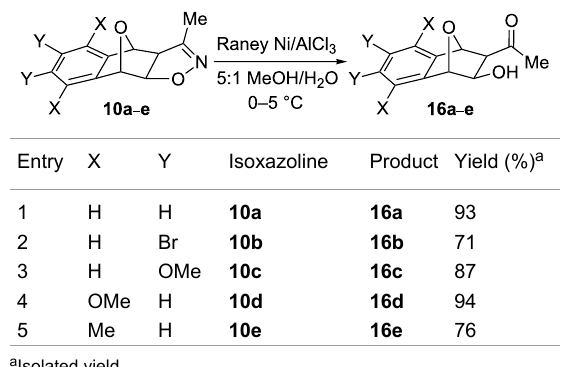
Table 2: Effects of arene substitution on Raney Ni/AlCl 3 -mediated cleavage of symmetrical 7-oxabenzonorbornadiene-fused 3-methyl-2-